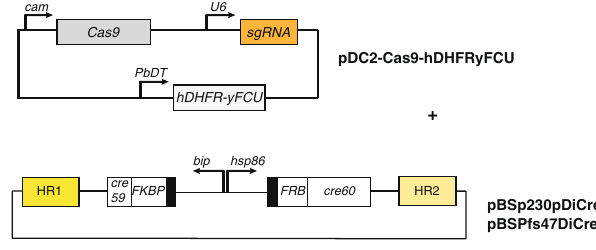
Figure 2. Toolkit plasmids for efficient integration of DiCre recombinase into p230p or pfs47 loci of the P. falciparum genome. The CRISPR-Cas9 plasmid used here, pDC2-Cas9-hDHFRyFCU (derived from pDC2-Cas9-U6-h dhfr 27 ) carries the SpCas9 nuclease gene and a single guide RNA cassette driven by a short U6 promoter and the h dhfr -y fcu fusion gene for selection. The rescue plasmids (pBSp230pDiCre and pBSPfs47DiCre) contain the genes for the split Cre-recombinase fused to FRB and FKBP12 respectively, flanked by regions of homology from the p230p or the pfs47 locus of P. falciparum . More detailed vector maps are available in Supplementary Fig.